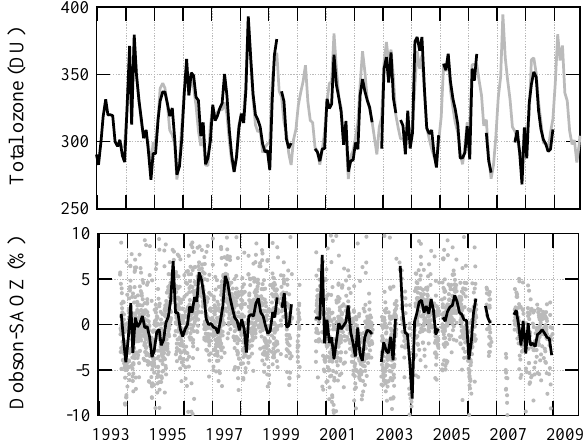
Fig. 6. Comparison between Dobson (black line) and SAOZ V2 (grey line) total ozone columns at OHP (upper plot). The relative difference Dobson-SAOZ V2 appears on the lower plot (grey dots: daily; black lines: monthly mean). SAOZ data in 1992–1993 are removed because of the Mount Pinatubo eruption. The difference shows a systematic seasonal cycle, and small systematic offsets be- tween periods of several years as well as sporadic jumps on some months. Since they do not correlate with changes in the satellite- SAOZ difference at OHP they cannot be attributed to SAOZ.